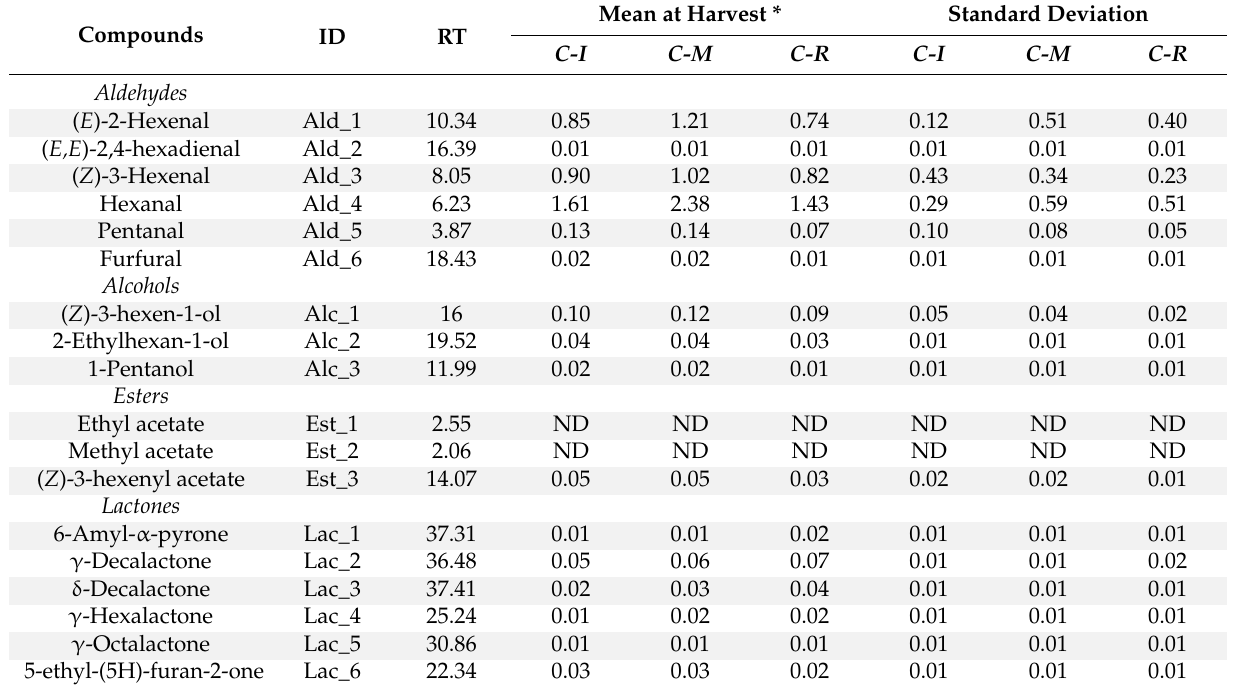
Table 3. Classes of volatile organic compounds (VOCs) most detected by SPME/GC-MS analysis of peaches at different maturity stages. For each compound the identification code (ID), the retention time (RT) and the average concentration (with standard deviation) assessed at harvest are